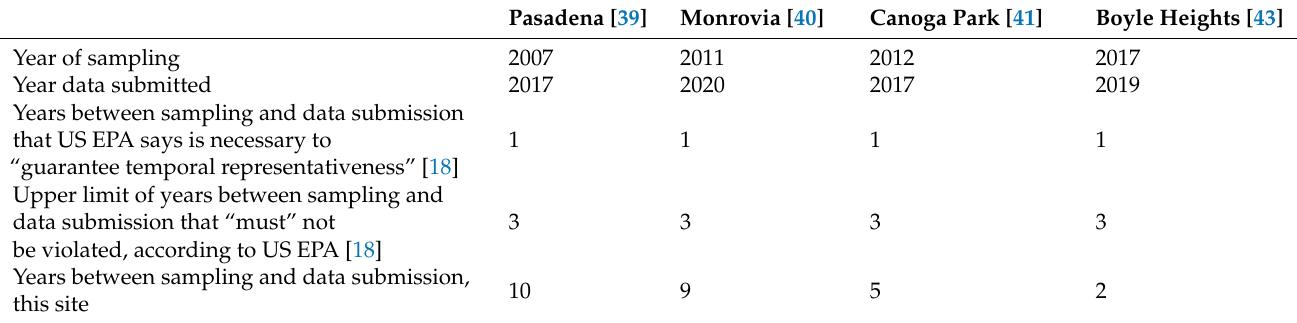
Table 3. Temporal representativeness of soil-gas sampling (RepQ1) at four toxic sites in